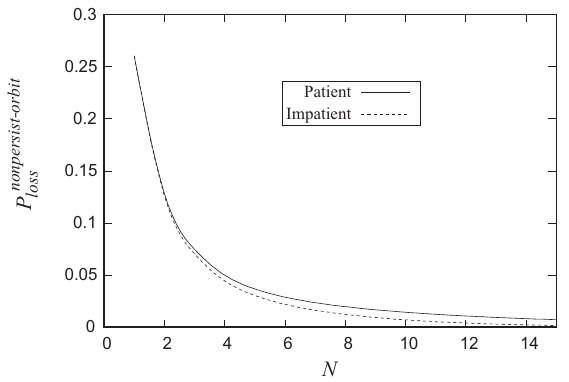
− orbit on the number N . loss